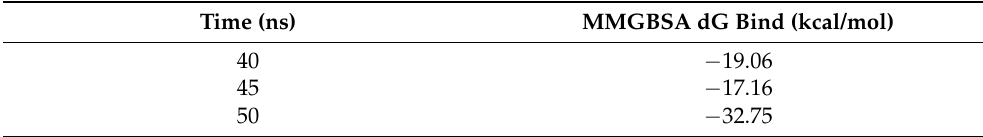
Table 2. Prime MMGBSA dG binding energies for the different binding modes represented in Figure 10. Time is expressed in nanosecond